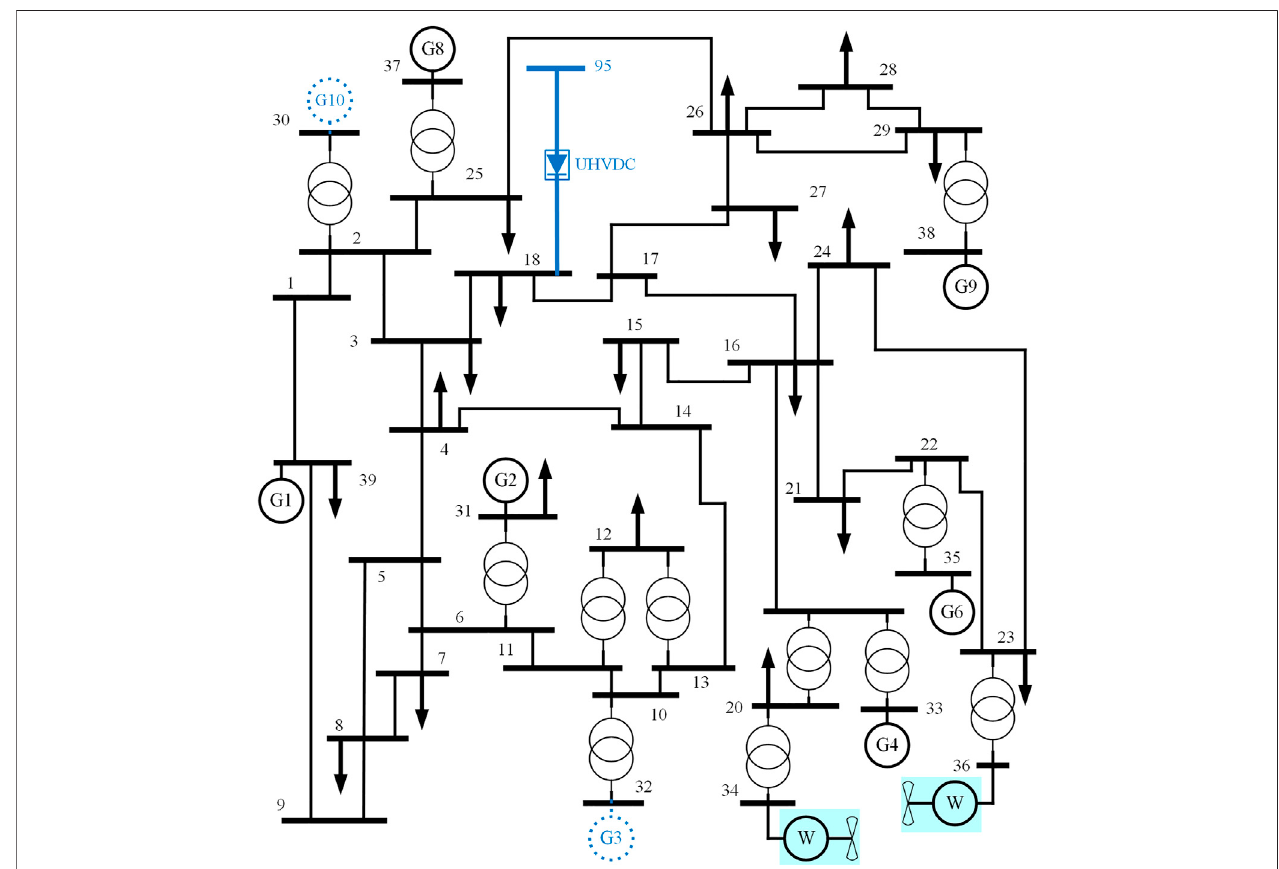
FIGURE 7 | Single-line diagram of the IEEE 39-bus test system with wind turbines and UHVDC.